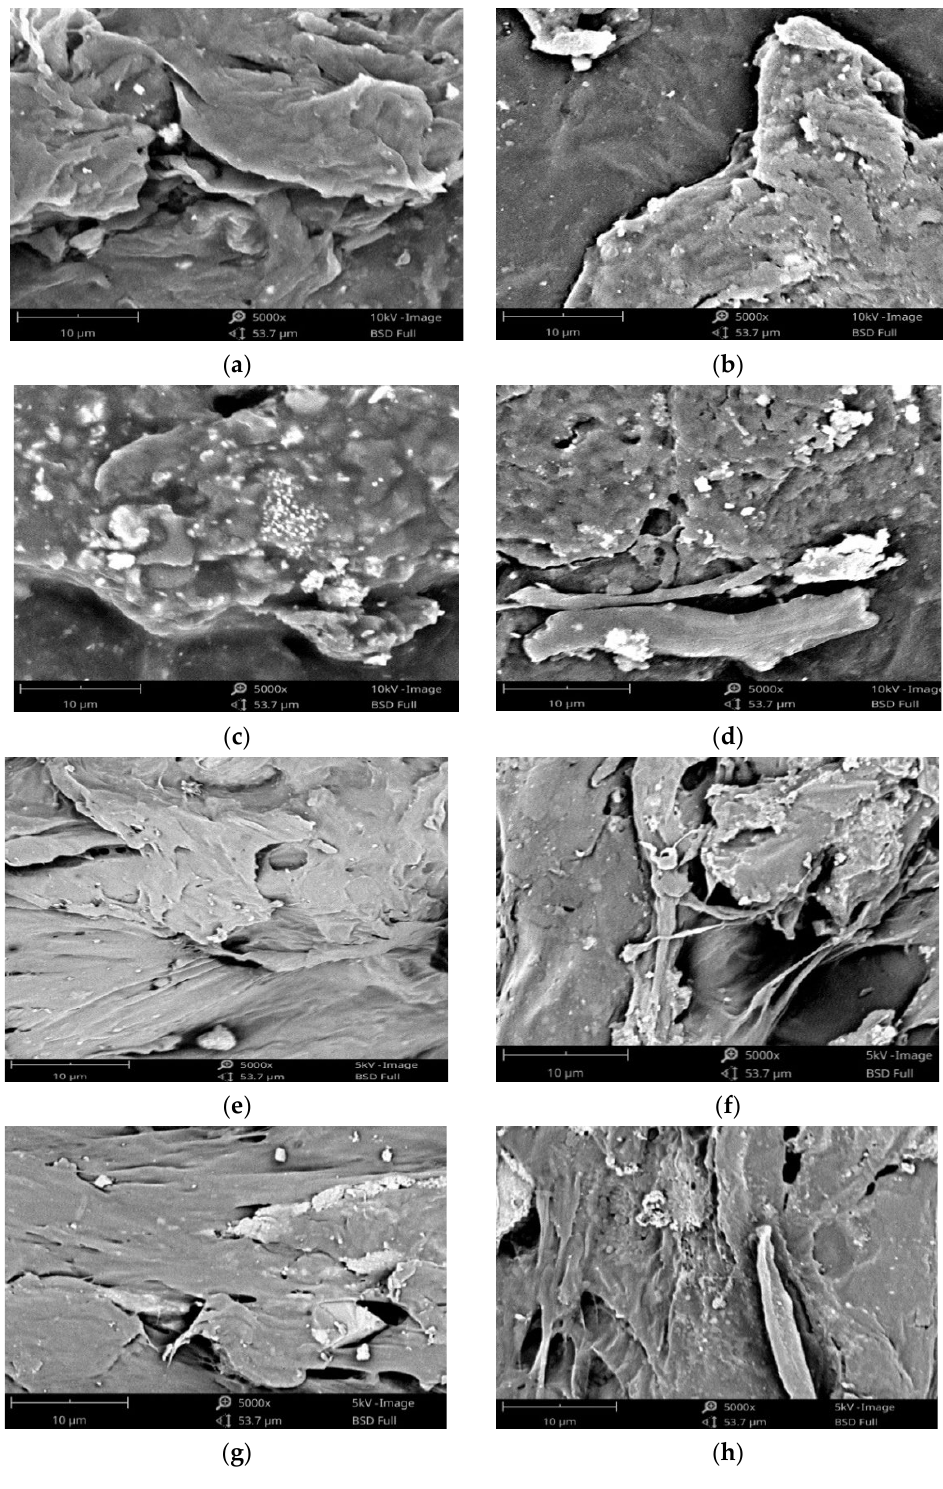
Figure 9. SEM images of biocomposites at 5000× magnification: ( a ) PLA40/PCL60/HA5; ( b ) PLA40/PCL60/HA10; ( c ) PLA40/PCL60/HA15; ( d ) PLA40/PCL60/HA20; ( e ) PLA85/PCL15/HA5; ( f ) PLA85/PCL15/HA10; ( g ) PLA85/PCL15/HA15; ( h ) PLA85/PCL15/HA20.